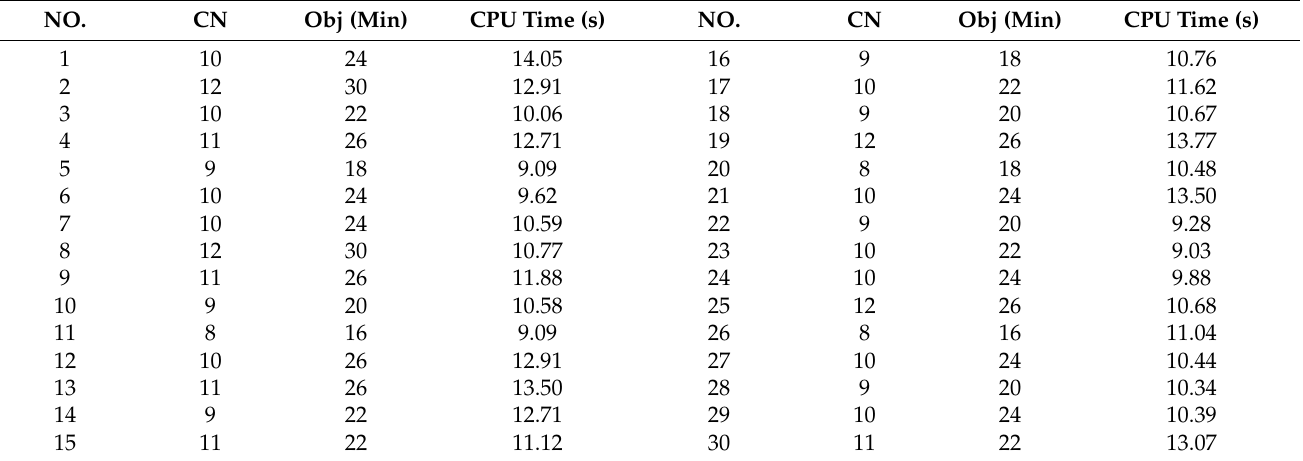
Table 2. Phase one